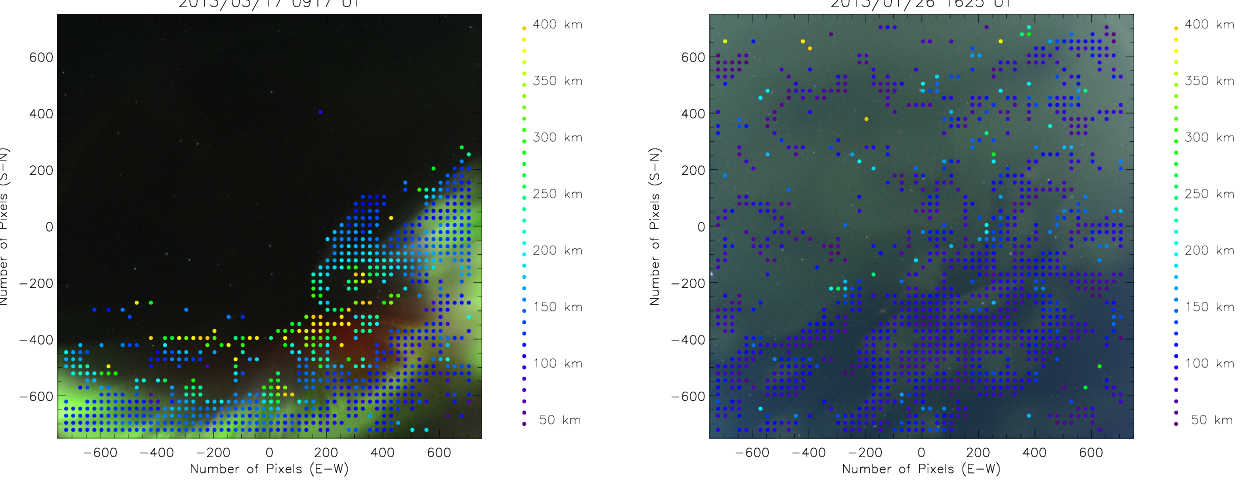
Fig. 5. Altitude map of a patchy structure of a pulsating aurora as obtained from all-sky images in Fig. 2. The format is the same as Fig. 4.